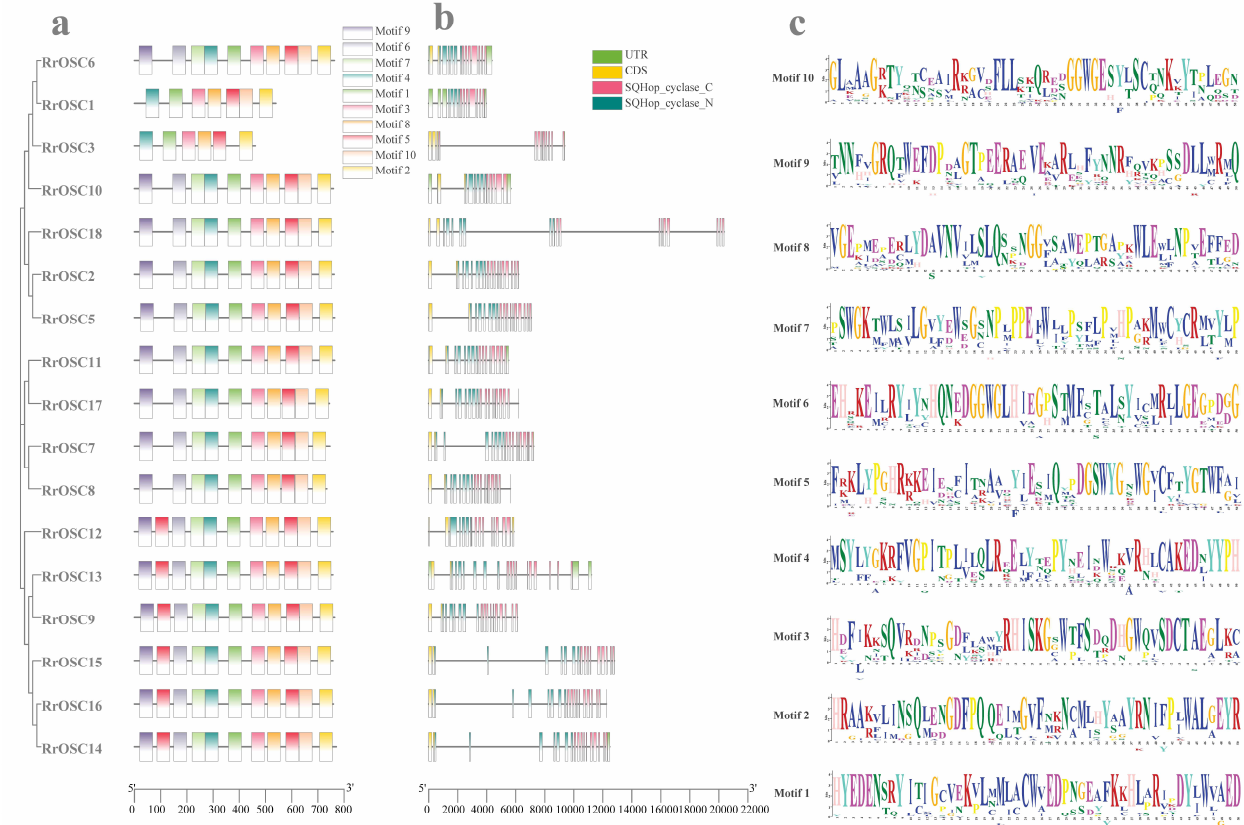
Figure 2 . Motifs ( a ), gene structures ( b ), and motif sequences ( c ) of RrOSCs . The coloring boxes represent motifs whose locations were labeled by the scale plate of amino acid residue ( a ). Exons (rectangles) separated by introns (lines) were colored yellow (coding sequence) and green (untrans- lated region), and the locations were labeled by the nucleotide scale plate. Domains were colored purple (SQHop_cyclase_C) and blue (SQHop_cyclase_N) ( b ). The top 10 significantly enriched motifs are listed as sequence logos ( c ).